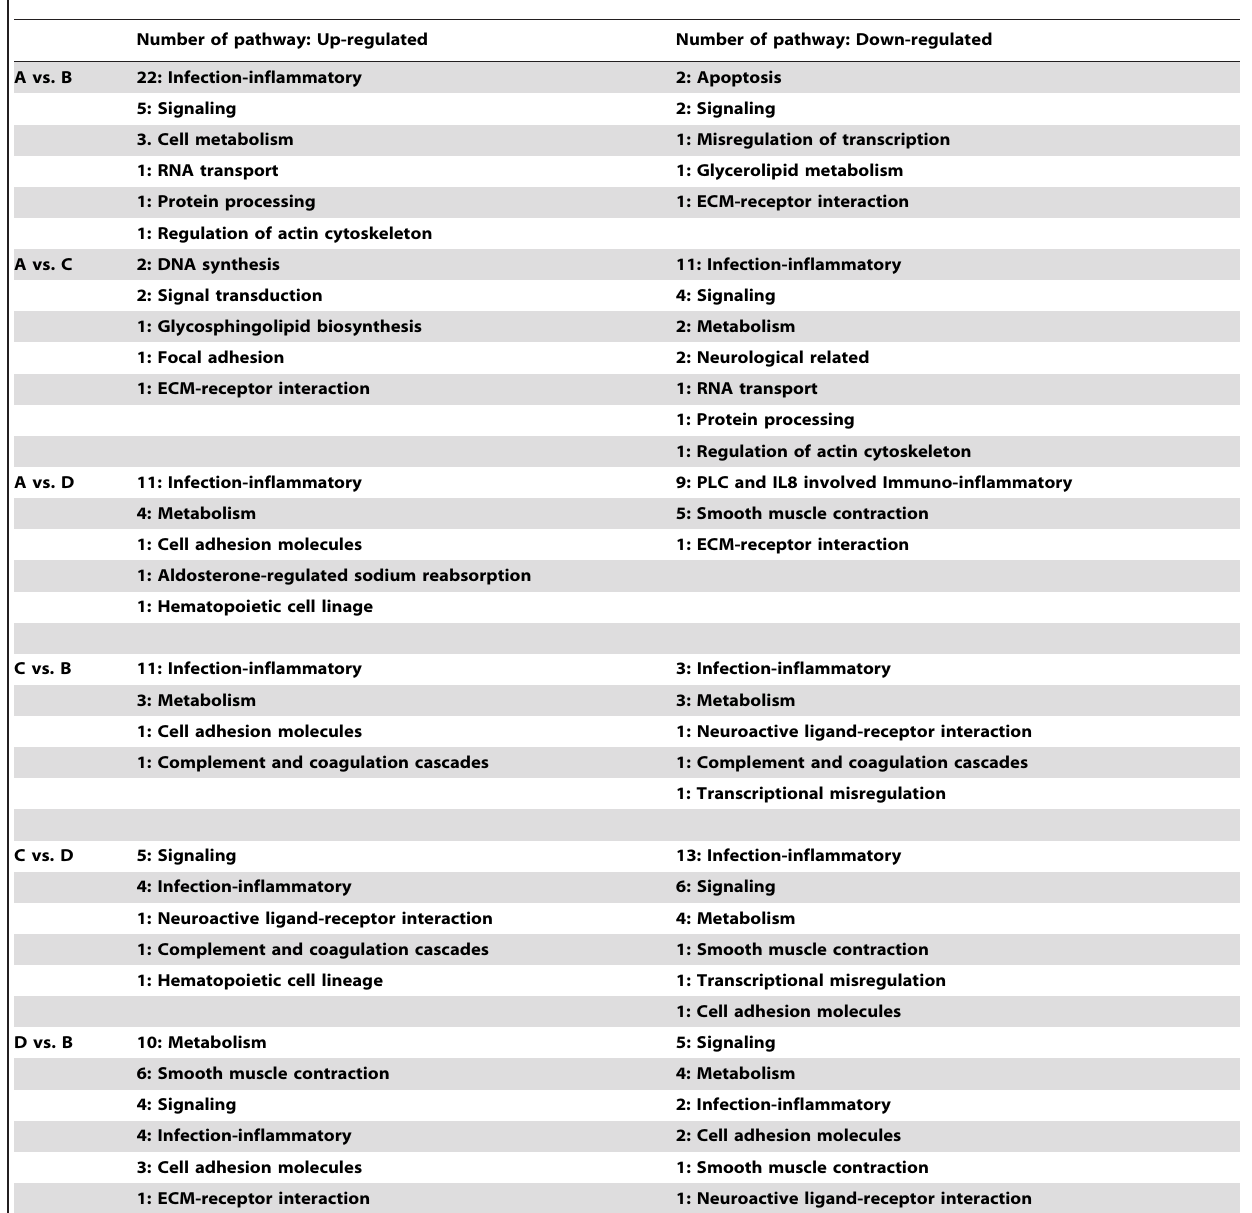
Table 3. PPROM pathways identified from differentially expressed lncRNAs.